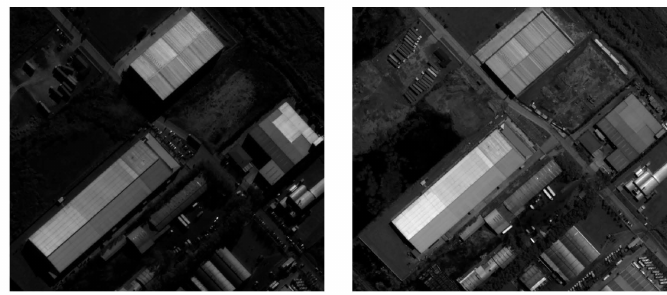
Figure 12. An example image tile in Pair